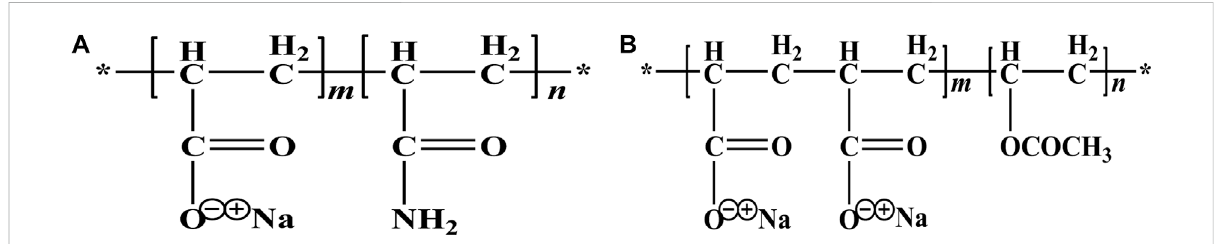
FIGURE 1 Molecular structure of partially hydrolyzed polyacrylamide (A) and the copolymer of vinyl acetate and maleic acid (B) (both neutralized by